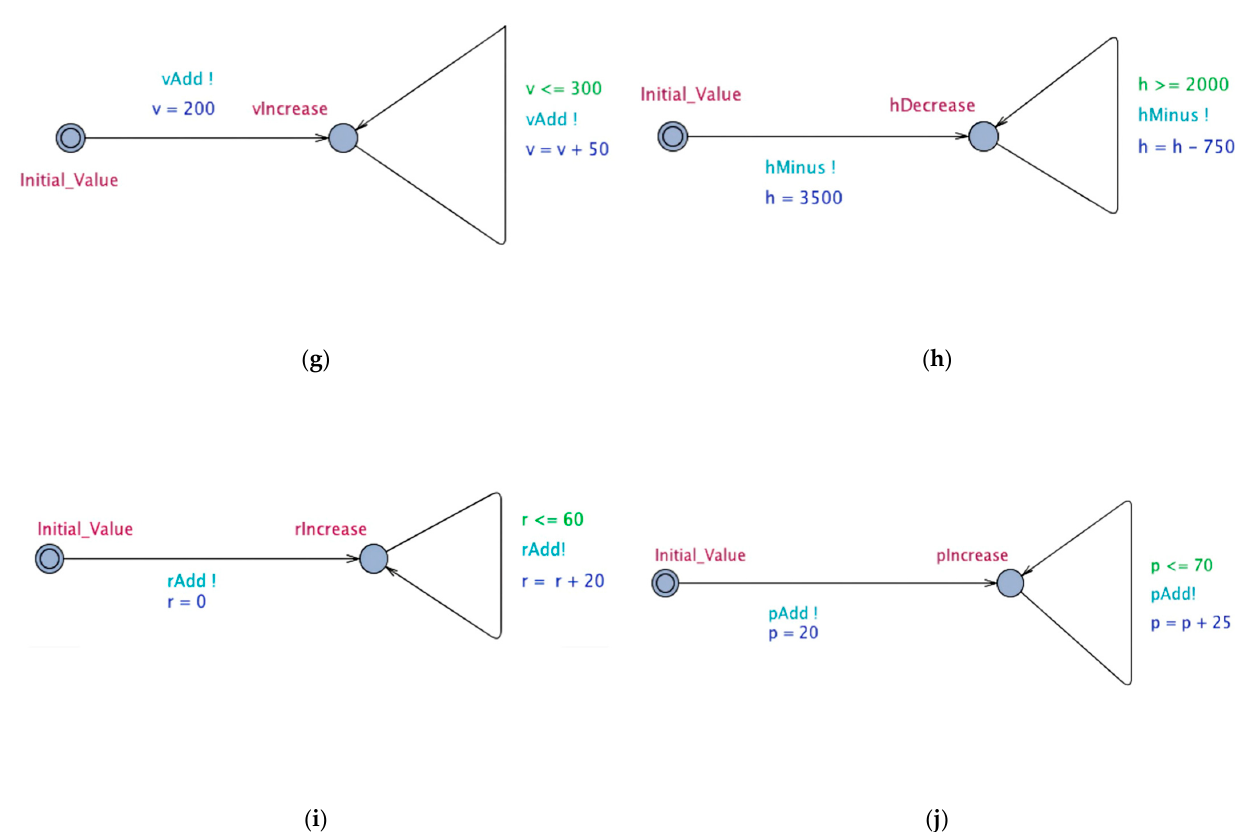
Figure 4. Timed automata of ten modules. ( a ) TA of Acc_Action. ( b ) TA of Sub_Action. ( c ) TA of Turn_Action. ( d ) TA of Jump_Action. ( e ) TA of Attack_Action. ( f ) TA of Finished_Action. ( g ) TA of Velocity. ( h ) TA of Height. ( i ) TA of Roll. ( j ) TA of Pitch.